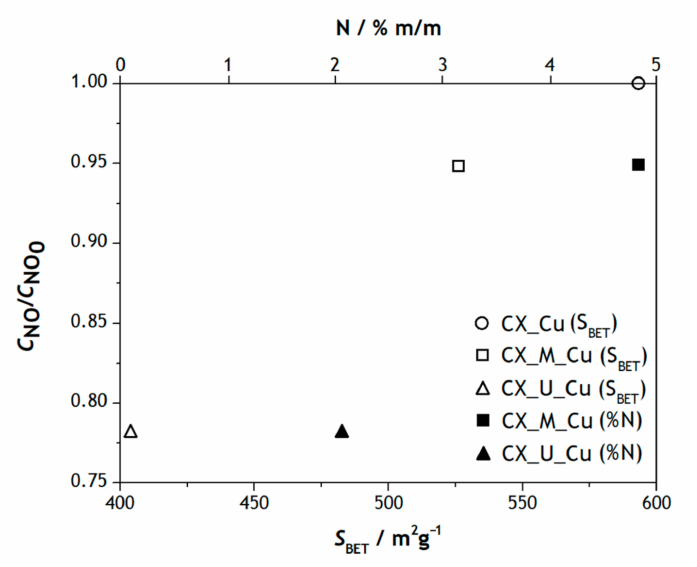
Figure 5. NO concentration in the presence of CX and CX_N with copper with [NO] = 1000 ppm in He with 5% of O 2 as a function of the specific surface area and the amount of